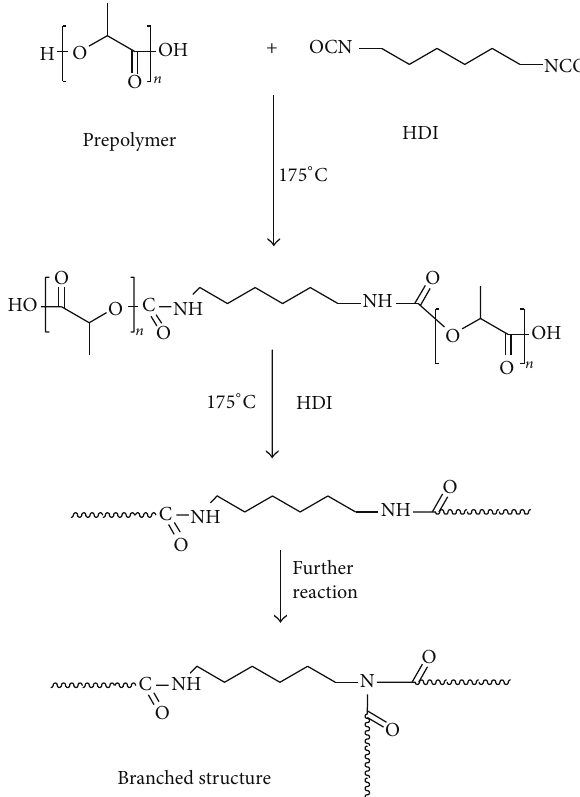
Figure 1: The synthesis scheme of the PLA chain extended with HDI.